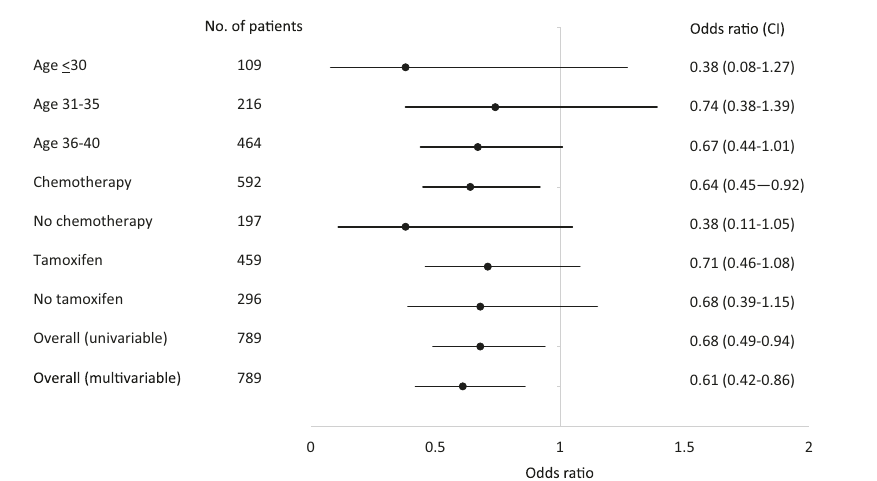
Fig. 1 Forest plot analyses to evaluate the association between BMI ≥ 25 (vs BMI 18.5 – 24.9) and 1-year treatment-related amenorrhea are shown. A consistent association between BMI ≥ 25 and a lower odds of 1-year TRA was present among each age group and by receipt or non-receipt of chemotherapy and